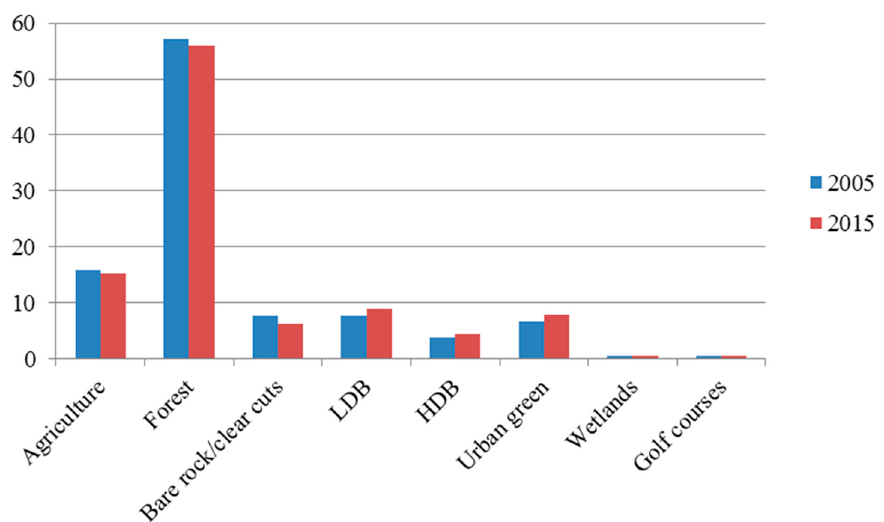
Figure 3. Land area percentage changes per land-cover class in Stockholm County between 2005 and 2015.